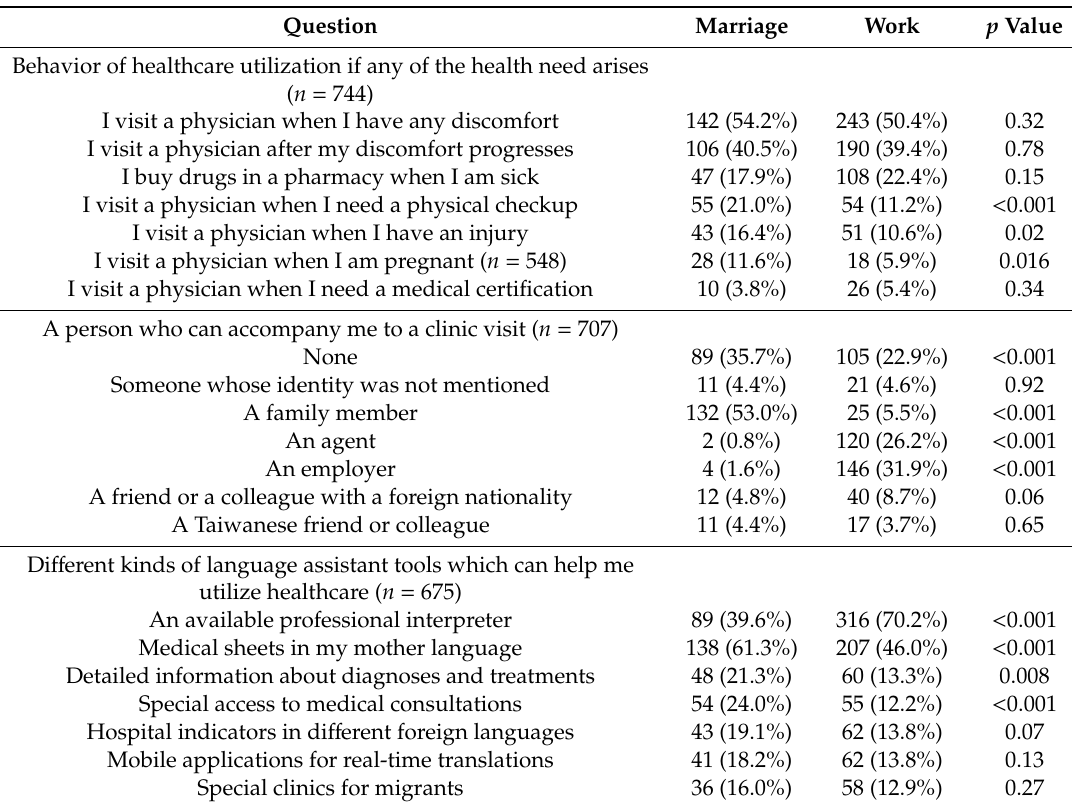
Table 4. Multiple-response questions associated with access of the study population to healthcare, stratified by reasons for migrating to